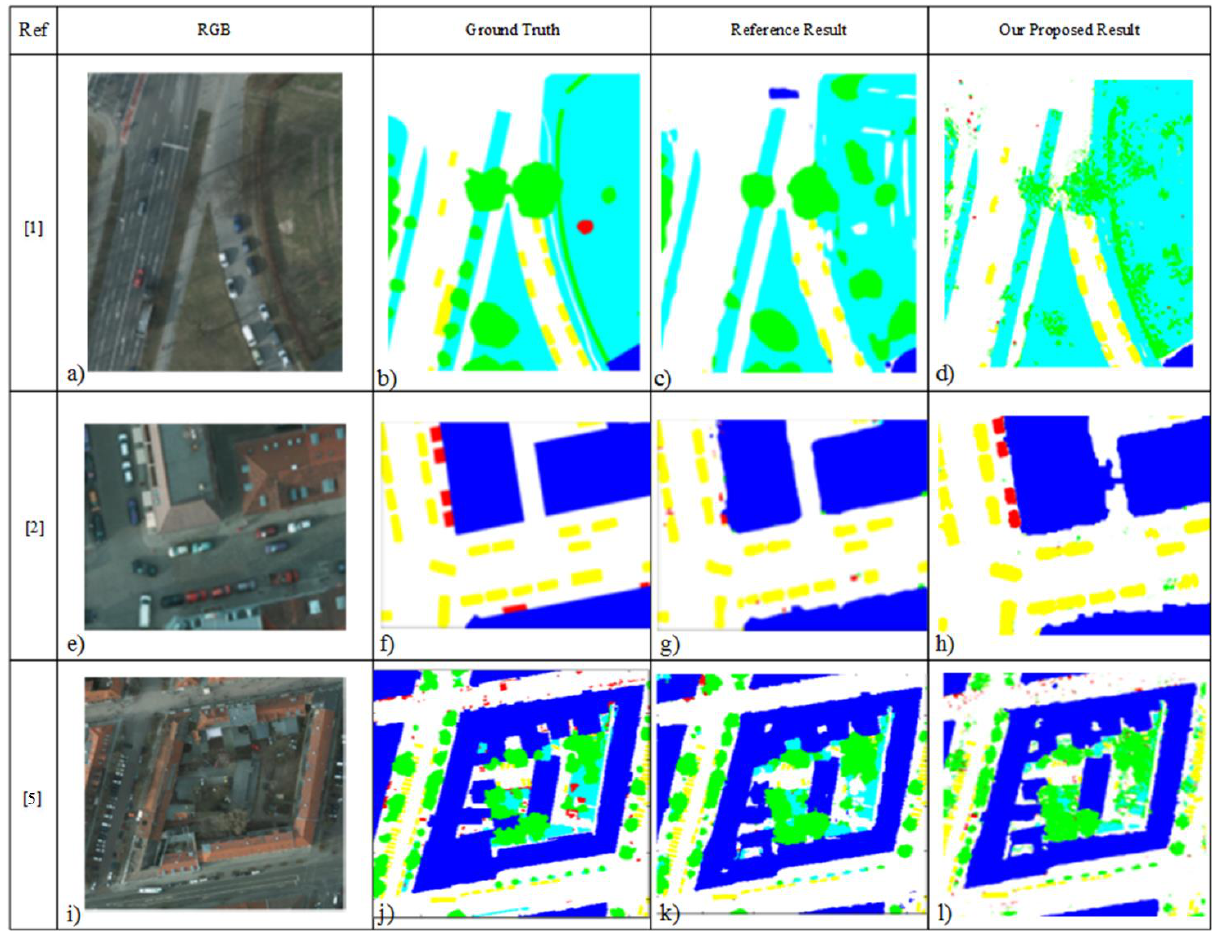
Figure 19. Visual result comparison between our proposed method and the previous works. The second column includes the original RGB images, where the corresponding ground truth is shown in the third column. The fourth column shows the reported results in the previous works, noted in the first column. The last column is the result of our proposed